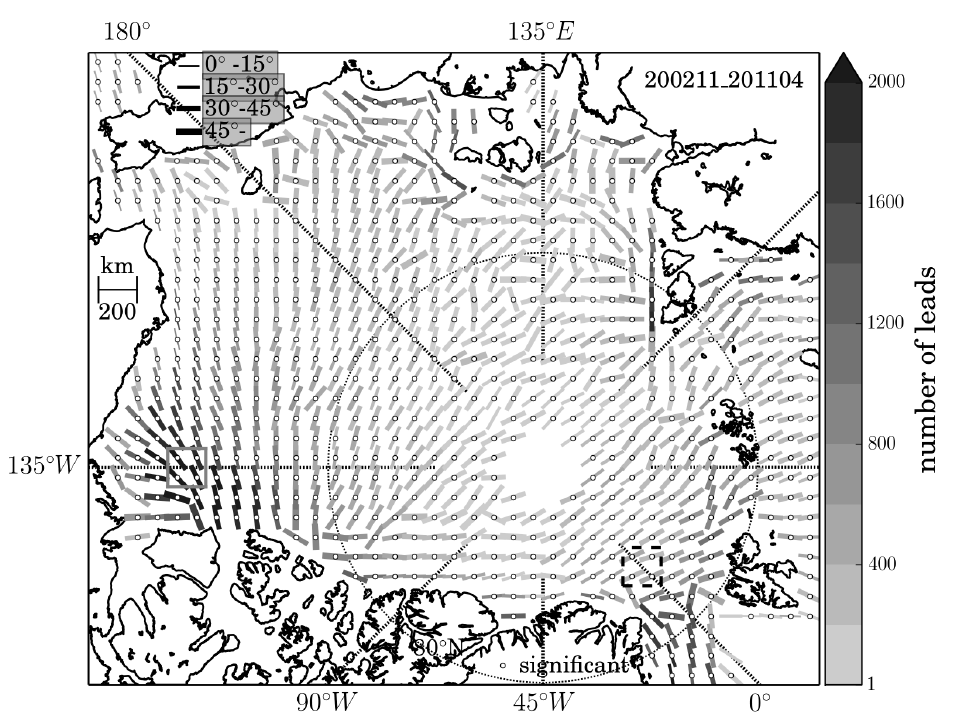
Figure 10. Average lead orientation from 2002 to 2011. Grey colors depict the number of leads while the width of a lead measures the standard deviation of all lead orientations in a 100 km × 100 km cell. White dots on top of a line indicate that the lead orientations are not randomly distributed on a confidence level of 99%. The black dashed and gray squares mark sub regions which are going to be analyzed in Section